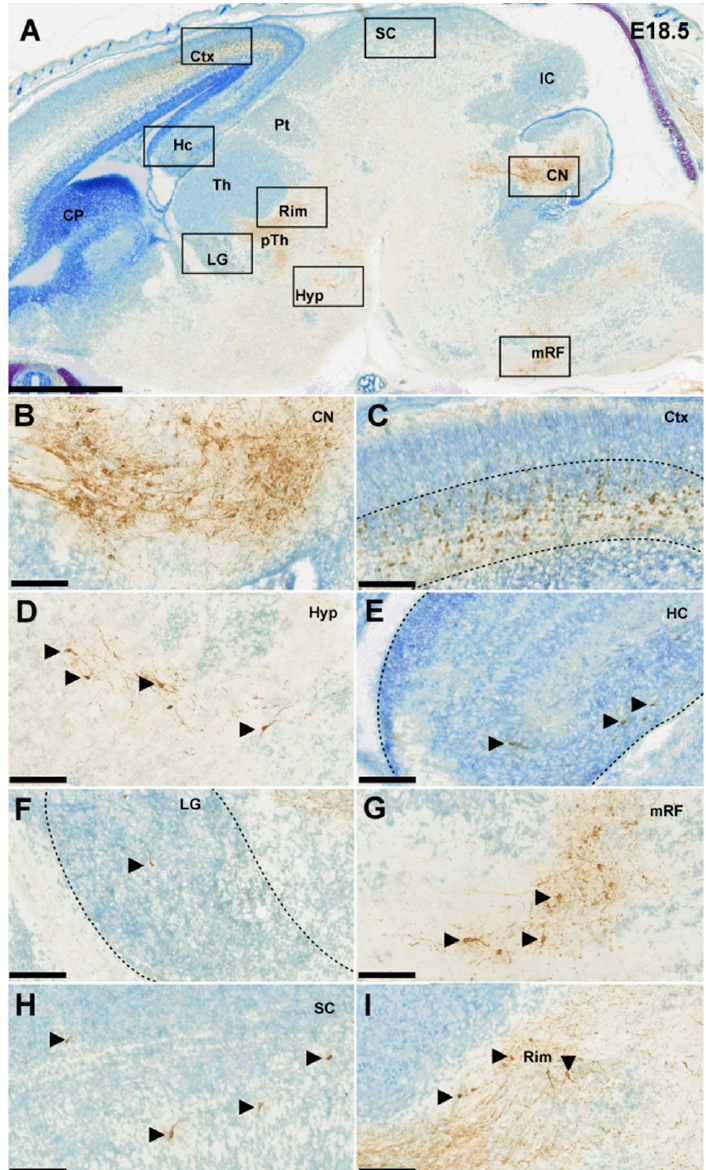
Figure 5. Ntsr1+ cells DAB-stained in an E18.5 embryonic mouse brain; counterstained with thionin. ( A ) Sagittal section showing all the regions in which Ntsr1 is expressed. Scale bar = 1000 µm ( B – H ) 20x zoom in pictures of the CN, the Ctx, the Hyp, the HC, the LG, the mRF and the SC, respectively. ( I ) 20× zoom in image of a region at the interface between thalamus and pTh with Ntsr1+ cells presumably originating from the Rim. Scale bar = 100 µm. CN = cerebellar nuclei, CP = caudate putamen, Ctx = cerebral cortex, HC = hippocampus, Hyp = hypothalamus, IC = inferior colliculus, LG = lateral geniculate nucleus, mRF = medial reticular formation, Pt = pretectum, pTh = prethalamus, SC = superior colliculus, Th = thalamus.